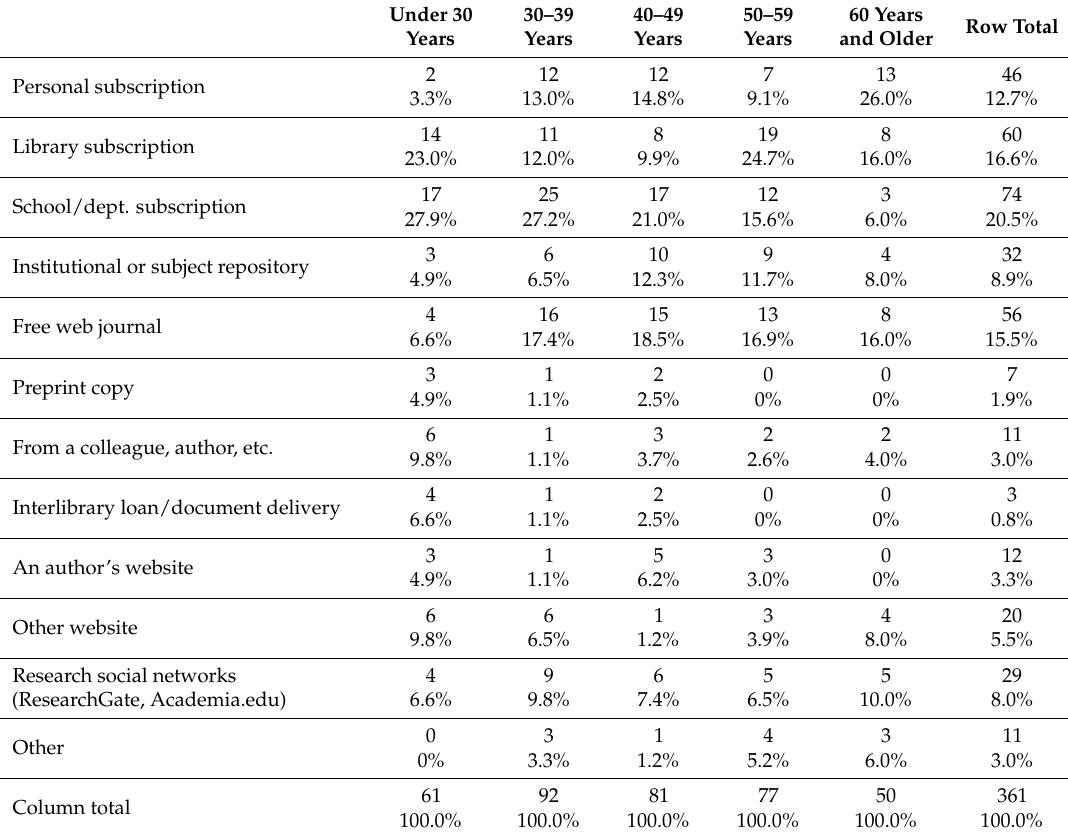
Table 19. Where articles are obtained by age group.